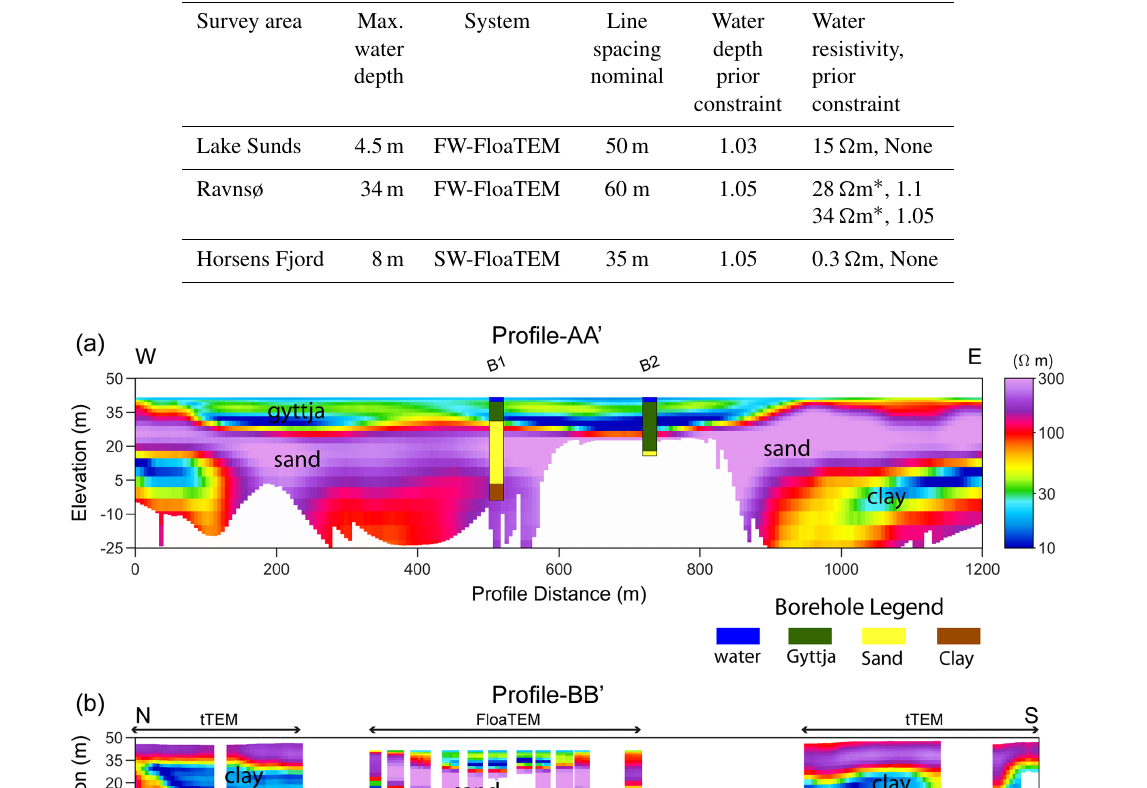
Table 2. Survey configuration and conditions of the three cases. The ∗ indicates that the water column was modeled with two resistivity layers.